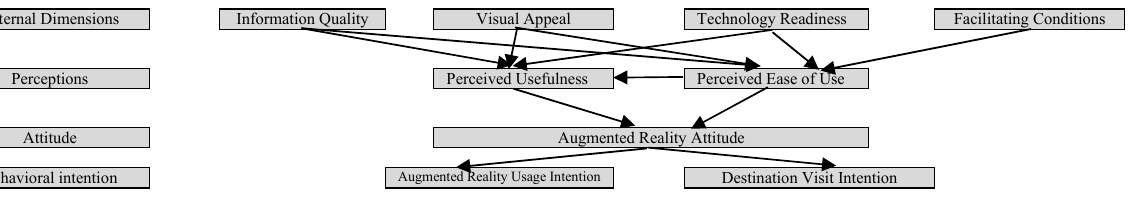
Fig. 6. An acceptance model for smart